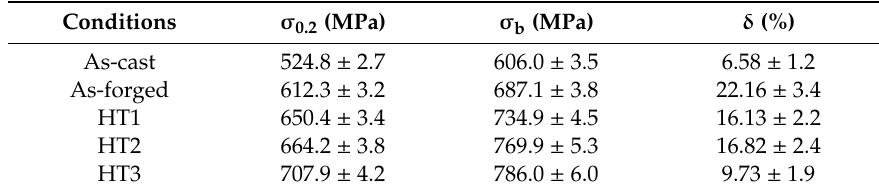
High-temperature tensile properties of the composites before and after thermomechanical processing.